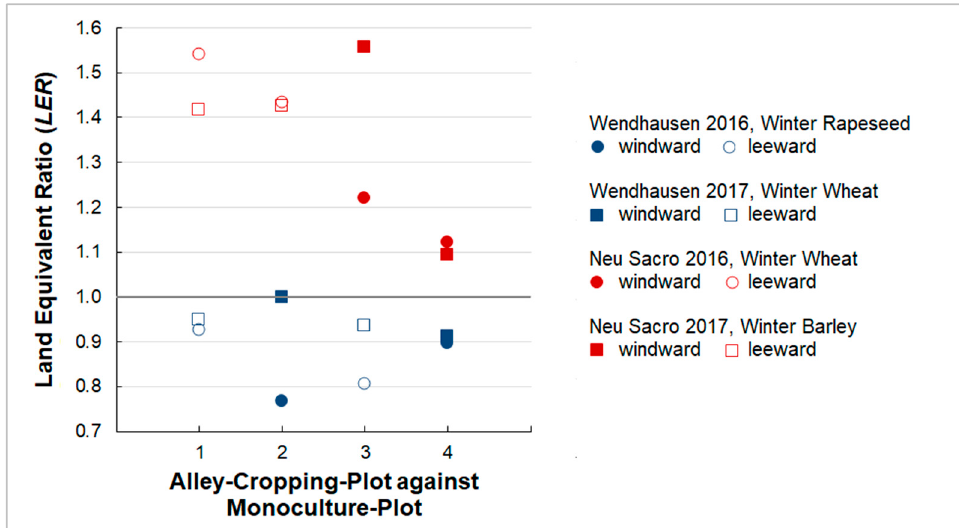
Figure 3. Annual land equivalent ratio (LER) obtained in 2016 and 2017 at Wendhausen and Neu Sacro. The grey line serves as a threshold above which the alley-cropping-plots have a greater productivity than the monoculture-plots.